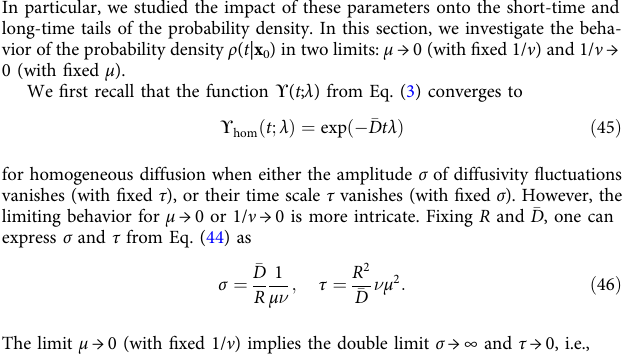
The limit μ → 0 (with fi xed 1/ ν ) implies the double limit σ → ∞ and τ → 0, i.e.,